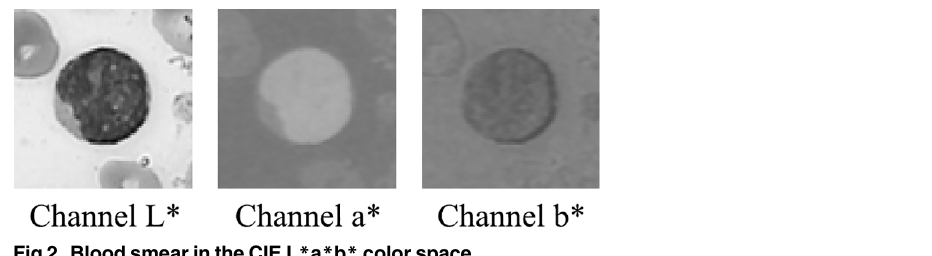
Fig 2. Blood smear in the CIE L * a * b * color space.